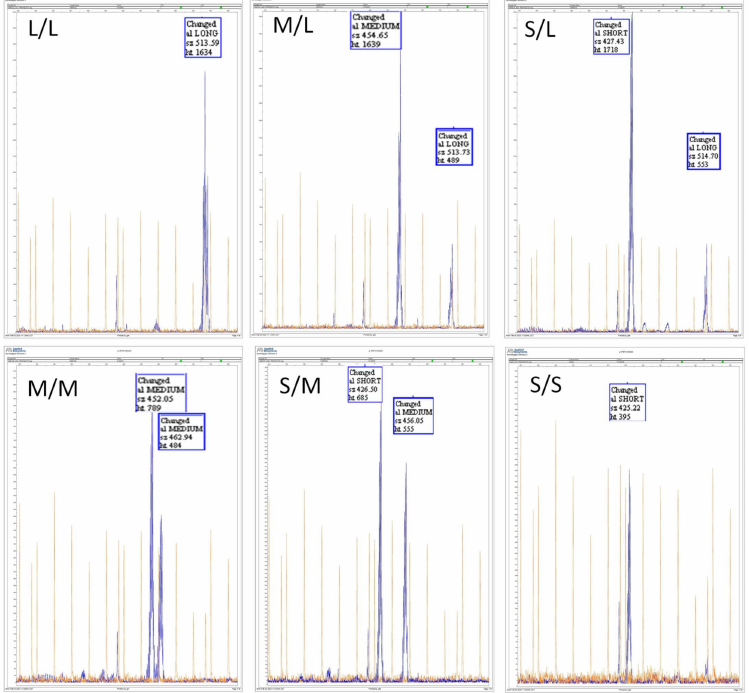
Figure 1. Electropherograms of six different Variable number tandem repeat polymorphisms ( pVNTR ) CYP2C9 diplotypes found in the studied population (S: 419–431 bp; M: 446–487 bp; L: 510–517